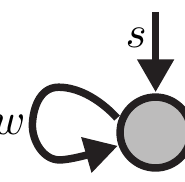
Figure 7: Connectivity diagram for a single dynamic neuron with self-excitation strength w and external stimulus s (Equation 12).